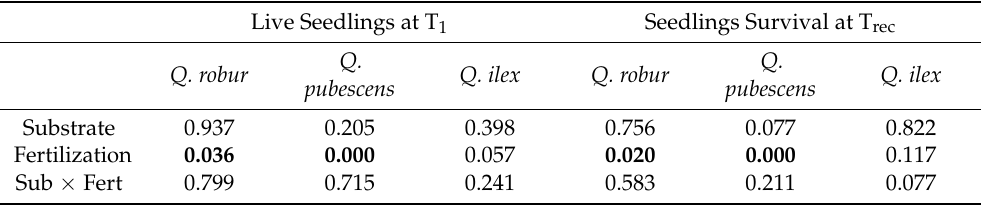
Table 1. GLM model results (P values) for percentage of live seedlings (not dry) at T 1 and survival at T rec of Quercus species after transplanted in controlled conditions under high water stress. In bold significant